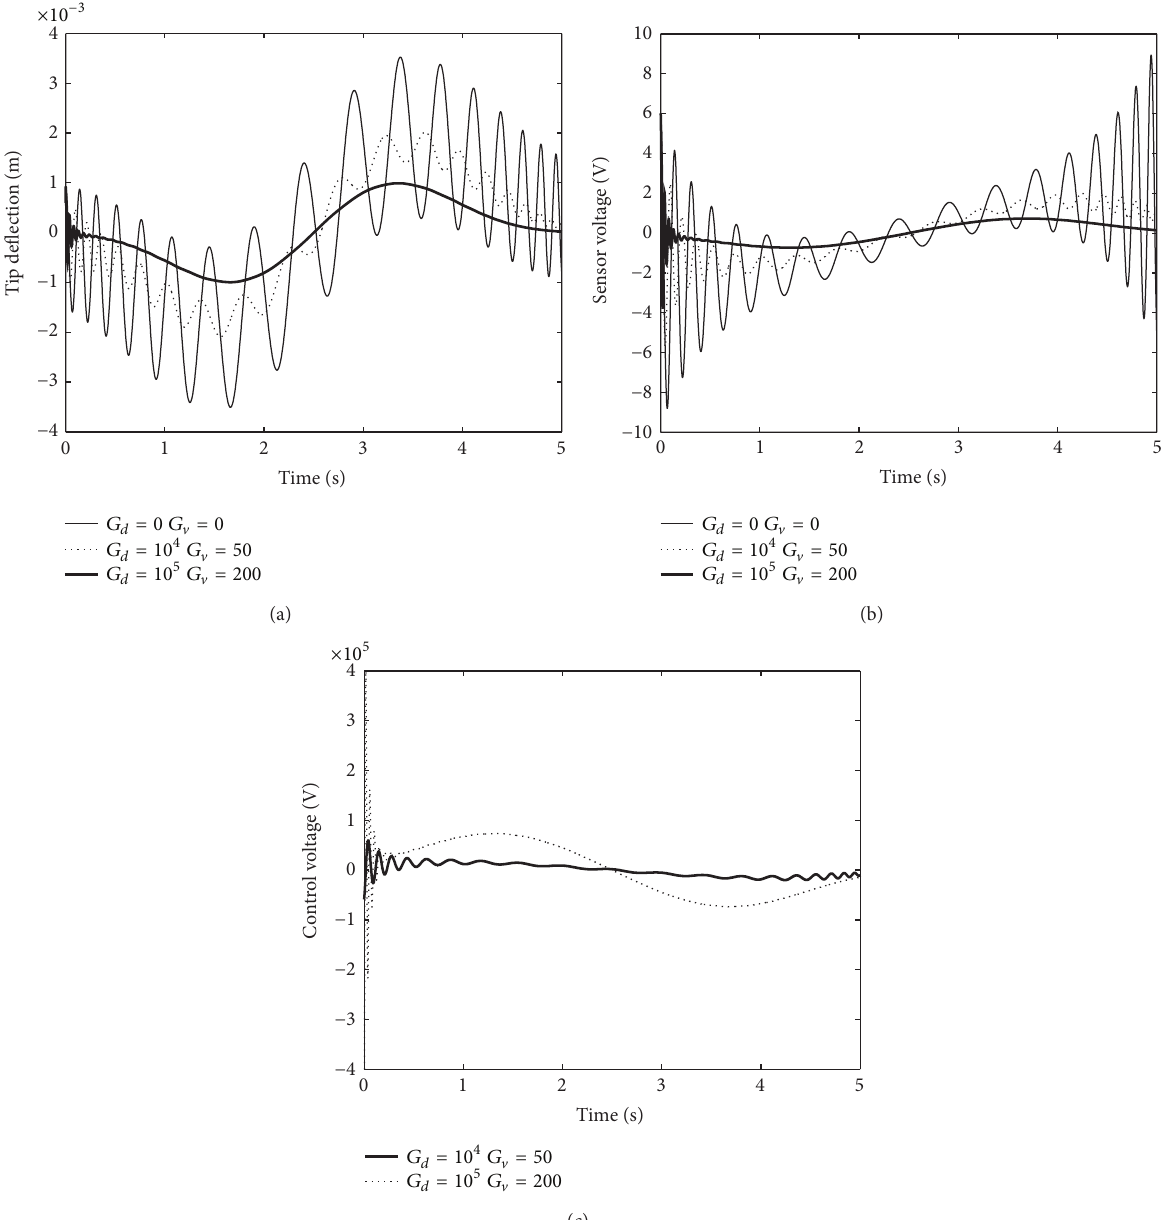
Figure 9: Tip deflection (a), sensor voltage, (b) and control voltage (c) of the arm under different control gain when 𝐿(𝑡) = 1 + sin (0.2𝜋𝑡) , ̇𝜃 = 0.2𝜋